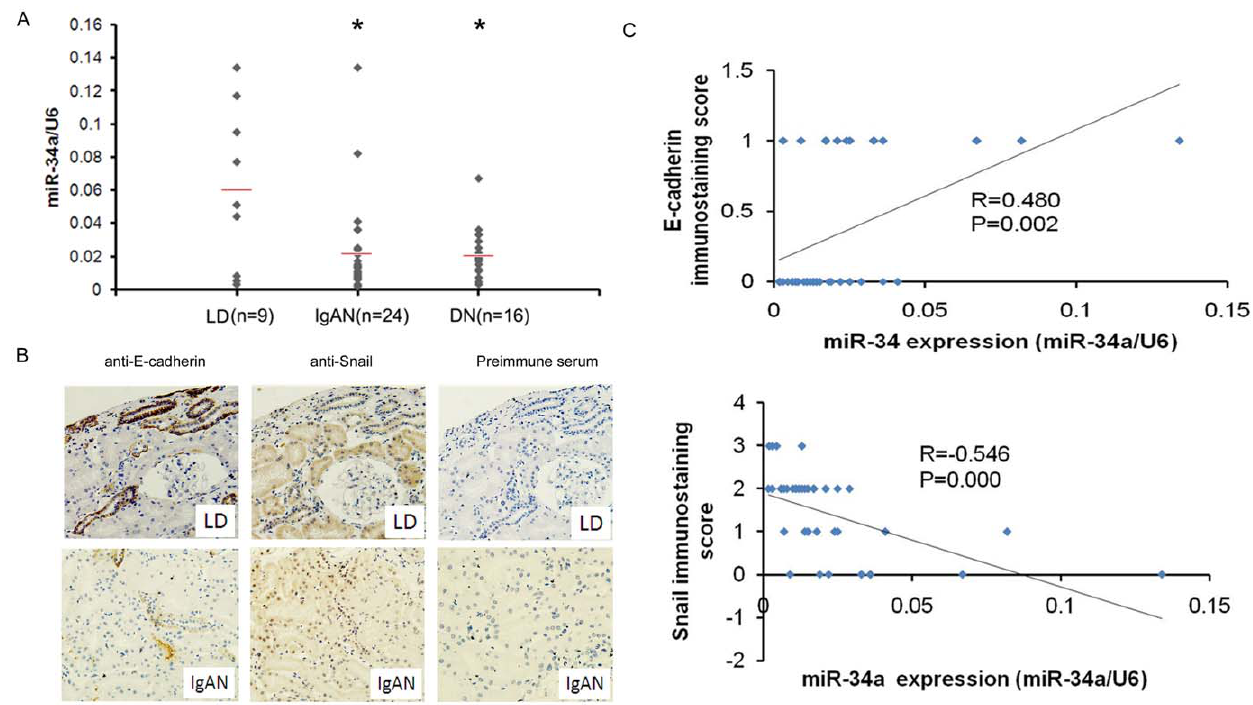
Figure 6. Expression of miR-34a in renal tissue from patients with CKD. (A) Expression analysis of miR-34a in renal tissue from patients with DN, IgA nephropathy (IgAN) by real-time PCR. Shown are relative expression values normalized to U6. Pretransplant biopsies from living donor kidneys (LD) were used as control. *P , 0.01 . (B) Expression of E-cadherin and Snail in renal tissue from living donor (LD) kidneys and patients with IgA nephropathy (IgAN) by IHC (original magnification, 400 6 ). (C) Scatter plot with fitted values intervals for tubular expression of miR-34a and E- cadherin (upper) or Snail (lower).